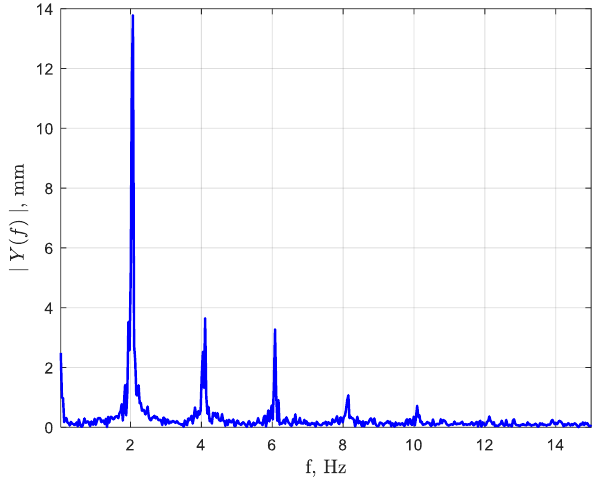
Figure 15. Fourier transform for rotating disk frequency of 3.4 Hz.